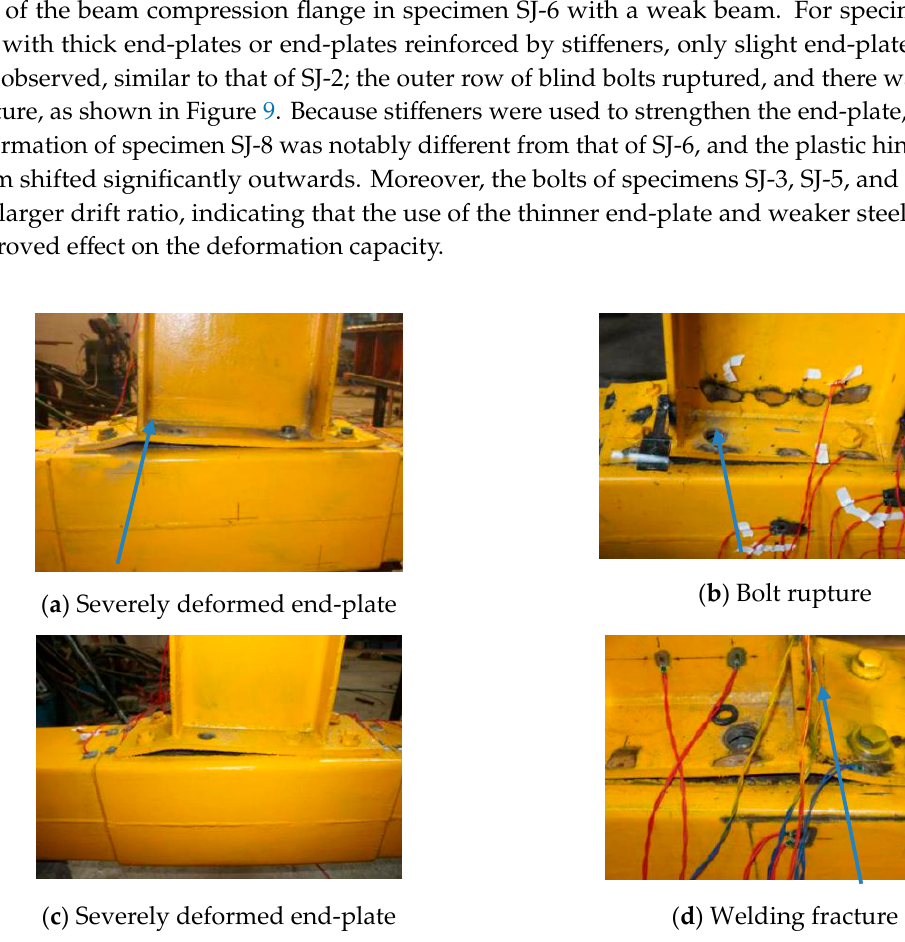
Figure 7. Failure mode I. ( a ) SJ-1; ( b ) SJ-2; ( c ) welding fracture in specimen SJ-1; ( d ) column wall